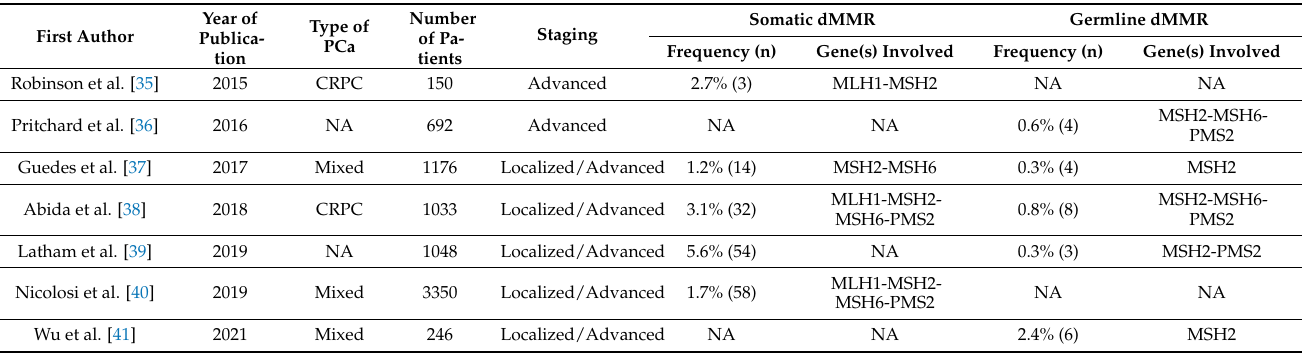
Table 1. List of studies that assessed the frequencies of somatic and germline mutations of MMR genes among PCa